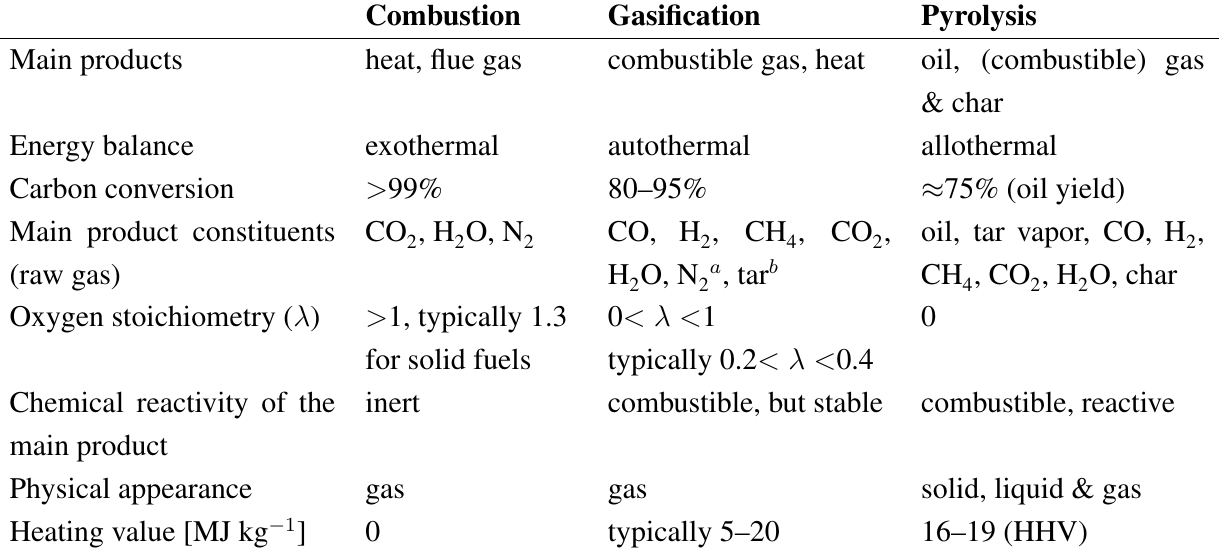
Table 4 . Main characteristics of the three thermochemical fuel conversion